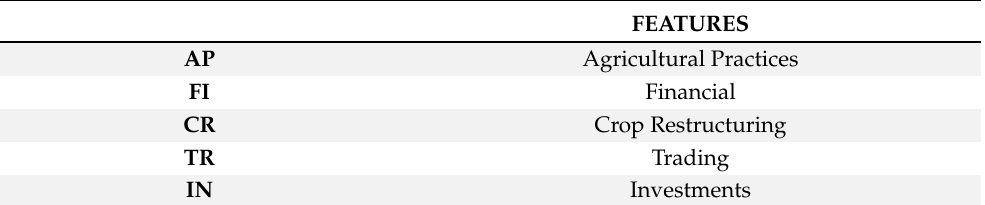
Table 4. Features of planning and control identified from the content analysis